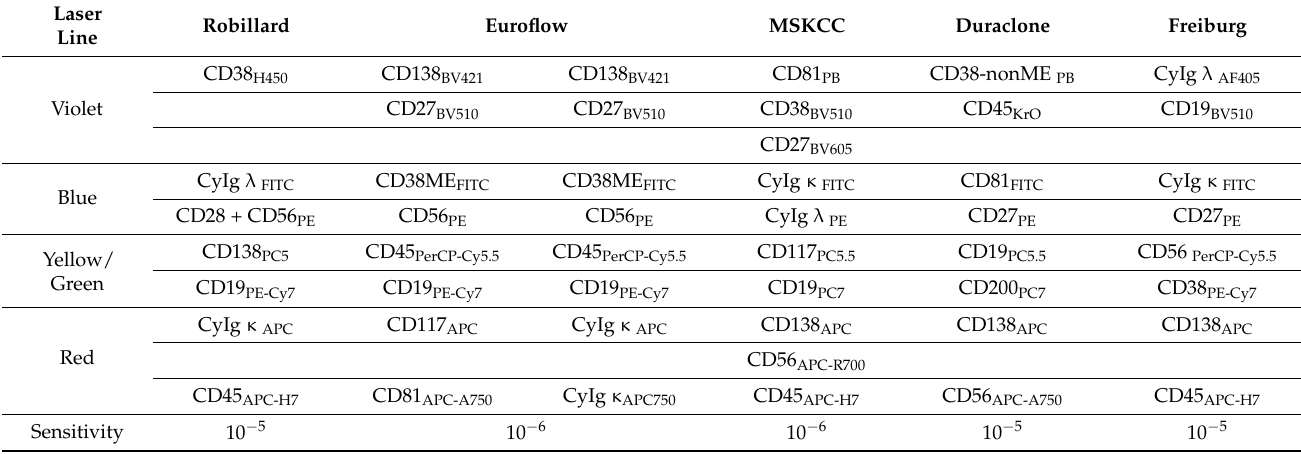
Table 1. MM Flow-MRD Panels with a sensitivity, at least, of 10 − 5